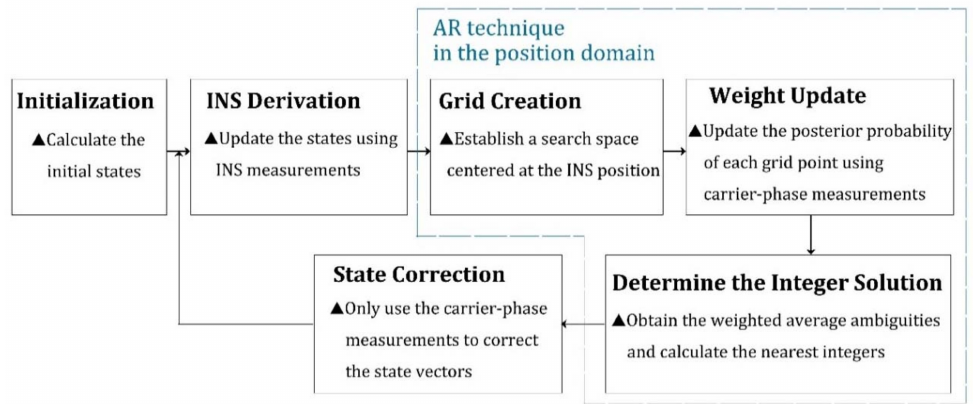
Figure 3. Overall flow chart of the ARPD-RTK/INS algorithm.